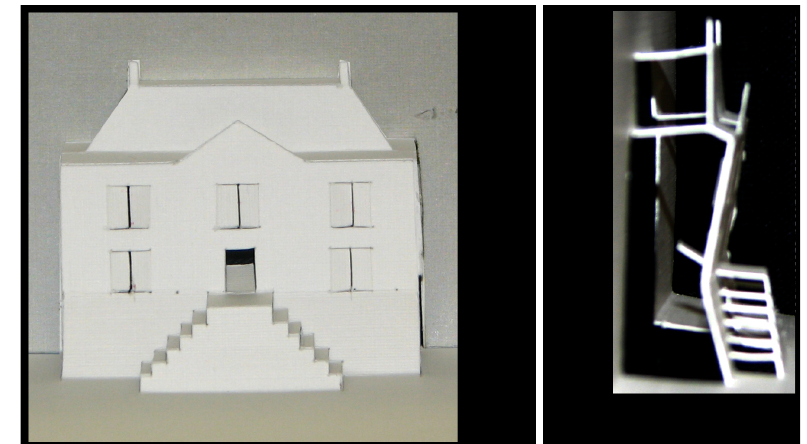
Fig. 2. A kirigami house made in